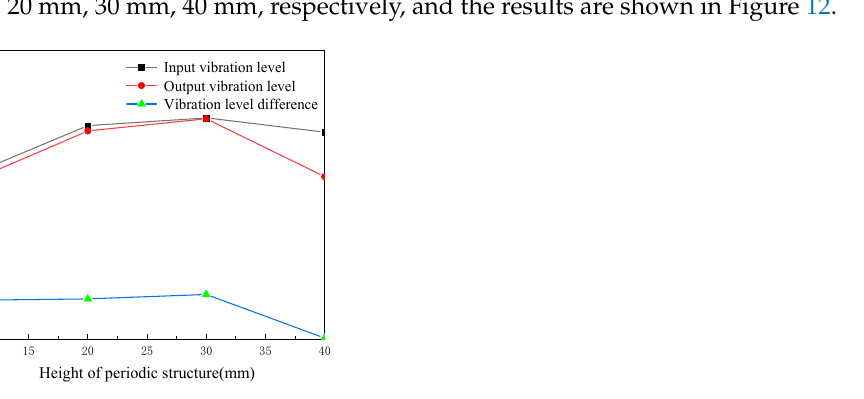
Figure 12. The effects of periodic structure height on cushioning performance (periodic structure width of 60 mm).